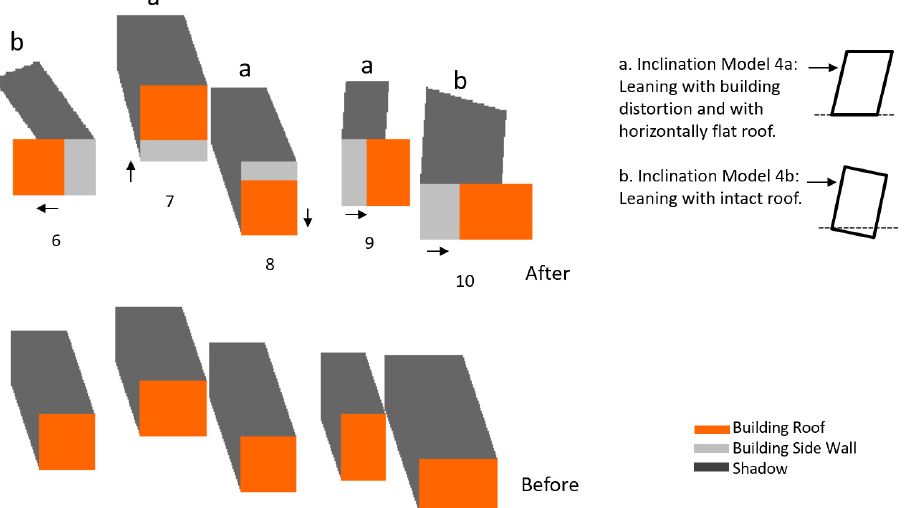
Figure 7. Detailed demonstration of building examples with two types of inclination damages for the Case A study.